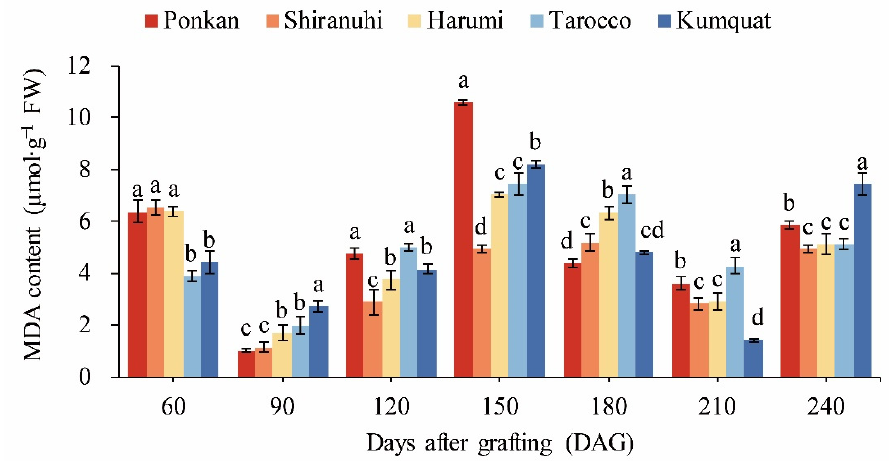
Figure 3. Effects of different interstocks on MDA content of ‘Yuanxiaochun’ citrus leaves. The data were analyzed using Duncan’s multiple range test in SPSS software. The lowercase letters indicate statistically significant differences among treatments ( p < 0.05), and the data are the mean ± SE of three replicates.